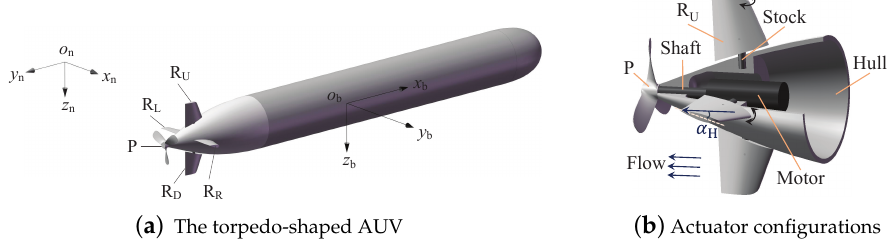
Figure 1. A torpedo-shaped AUV ( a ) and the actuators ( b ), where α H is a rudder angle from the plane x b o b y b